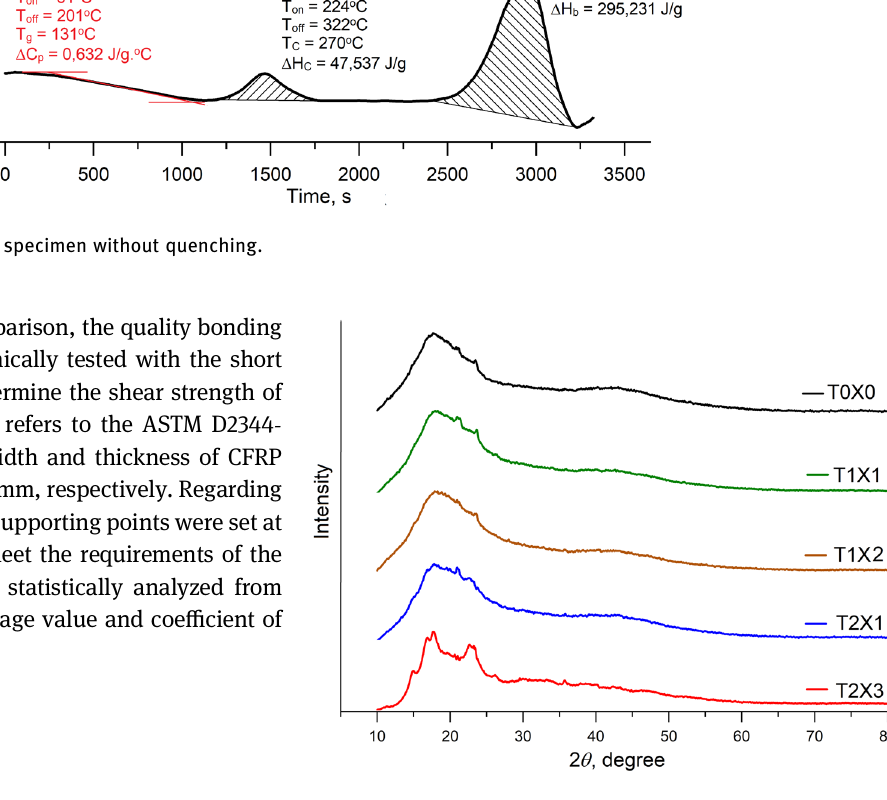
Figure 3: X - ray spectrum of the specimen before and after quenching